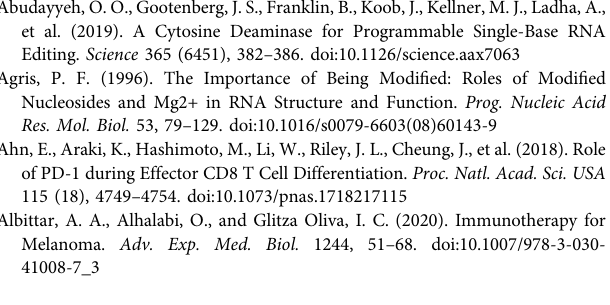
Supplementary Figure S1 | Overview of study design. Supplementary Figure S2 | Mutation characteristics of 26 A-related RNA modi fi cation “ writers ” in TCGA-SKCM cohort. (A) The mutation co-occurrence and exclusion analyses for 26 RNA regulators. Co-occurrence, blue; Exclusion, Khaki. (B) The prognostic analyses for 26 RNA regulators base on univariate Cox regression model. (C) GSVA enrichment analysis showed the differences between “ writers ” mutation and non-mutation tumors. Supplementary Figure S3 | CNVs regulating the “ writers ” expression in TCGA- SKCM cohort. P value less than 0.05 indicated a statistical difference. SupplementaryFigureS4| Thecharacteristicsoftumormicroenvironmentinthree RNA modi fi cation patterns. Evaluating the abundance of each tumor-in fi ltrating immune cell in three writer clusters using ssGSEA (GSE65904). (* p < 0.05; ** p < 0.01; *** p < 0.001).